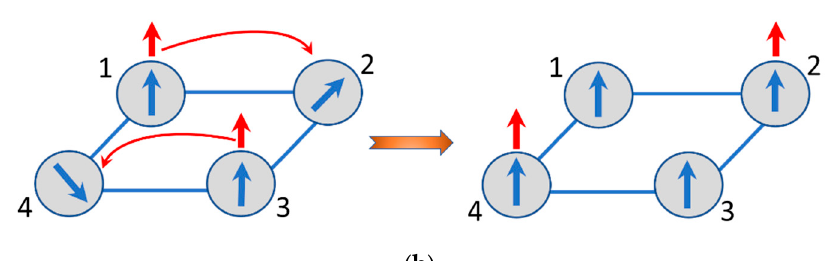
Figure 4. Illustration for the spin polarization effects in the tetrameric square-planar systems with two mobile electrons: antiferromagnetic spin alignment of delocalized spins ( a ); ferromagnetic spin alignment of delocalized spins ( b ).